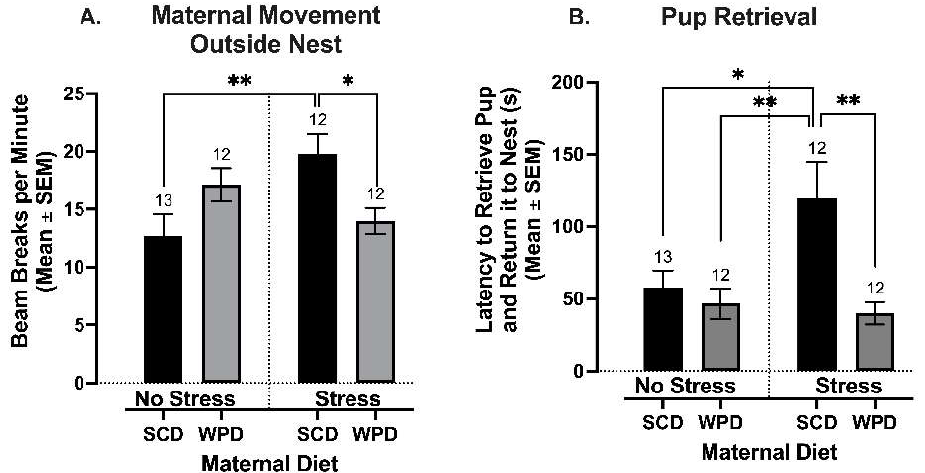
Figure 4. Maternal behavior represented by ( A ) the amount of time the dam spent moving around outside of the nest and ( B ) the amount of time it took for a dam to retrieve a displaced pup and return it to the nest. Group n ’s located above bars. WPD = Western pattern diet. SCD = standard chow diet. * p < 0.05, ** p < 0.01.